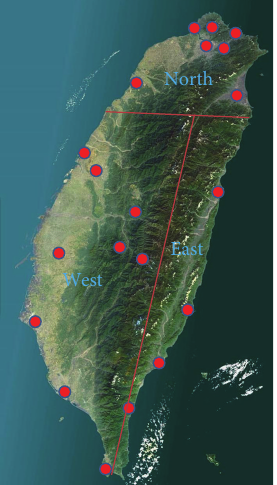
Figure 1: Points indicate the rain stations over Taiwan used in this study. The study area is separated into 3 regions: north, west, and